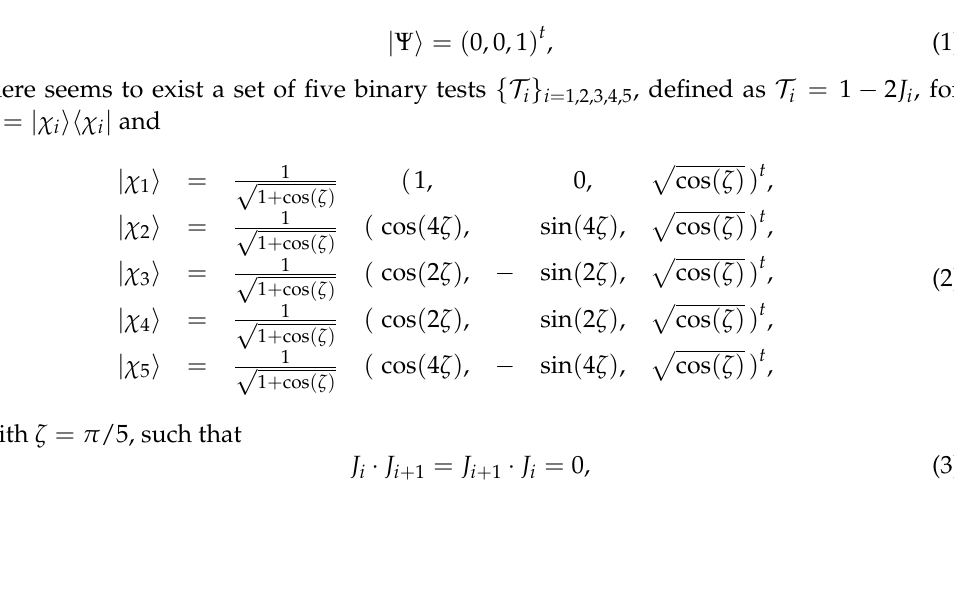
Figure 1. The five binary tests {T i } i = 1,2,3,4,5 considered by the KCBS theorem relative to the quantum state of the qutrit described by the wavefunction | Ψ (cid:105) . Each pair of consecutive tests T i , T i + 1 , i ∈ N mod ( defines a complete set of commuting observables, that is, a context . We argue in this paper that all these five contexts are related by a gauge transformation and are, therefore, physically